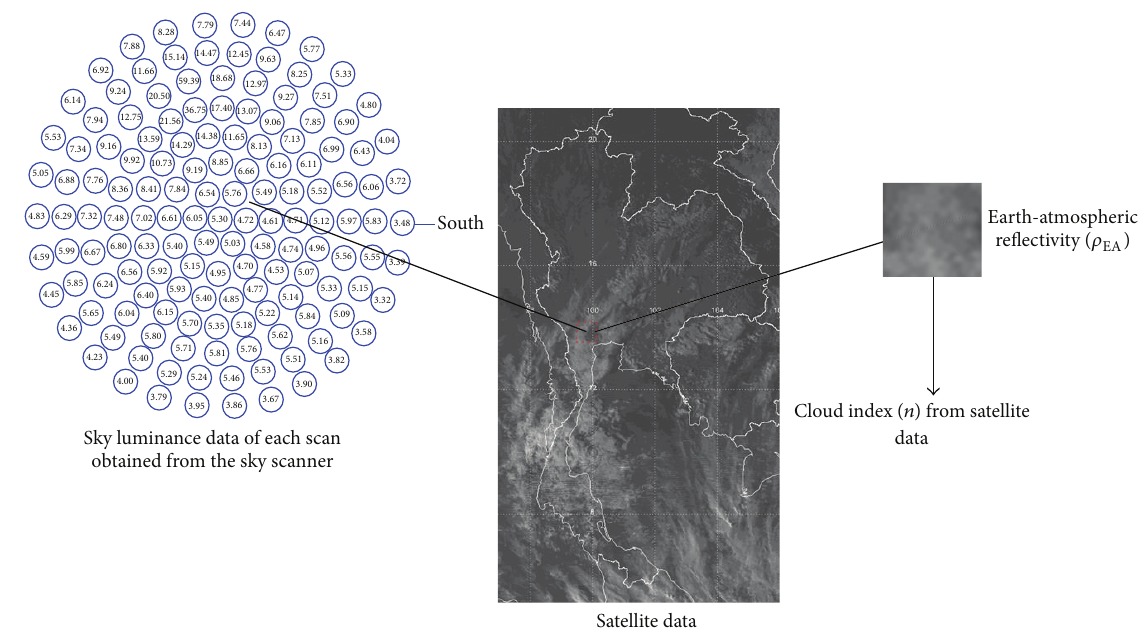
Figure 2: Example of satellite data used for deriving the cloud index ( n ) and the corresponding sky luminance data obtained from the sky scanner at Nakhon